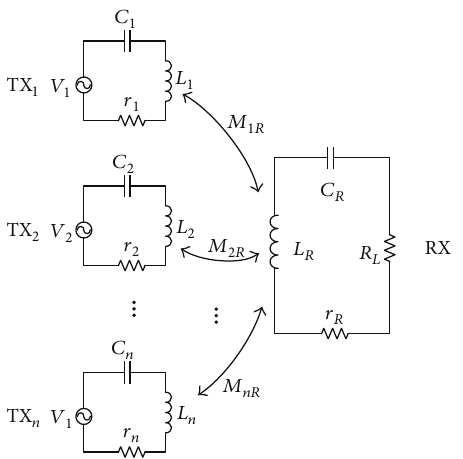
Figure 1: Circuit model of a multiple-TX single-RX WPT